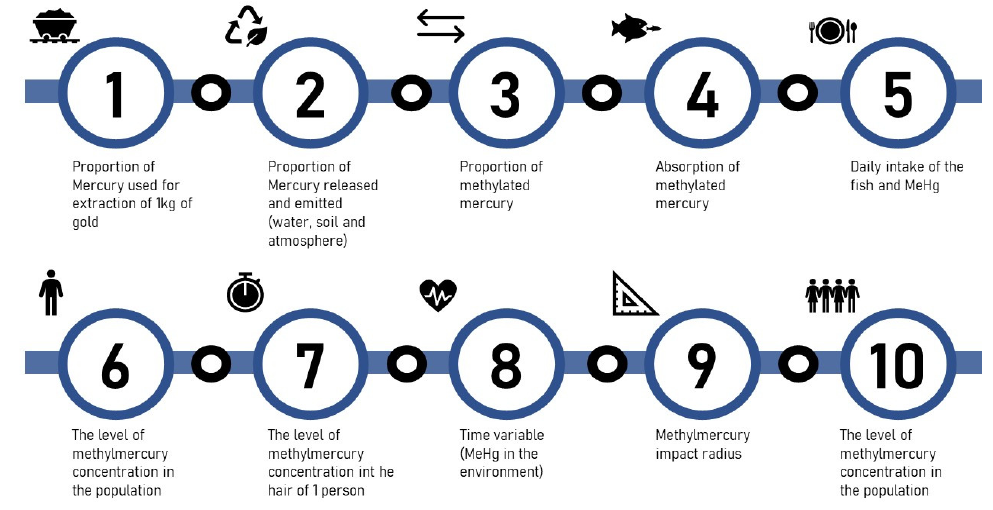
Figure 1. Logical line for relating the existence of gold mining to human health outcomes.